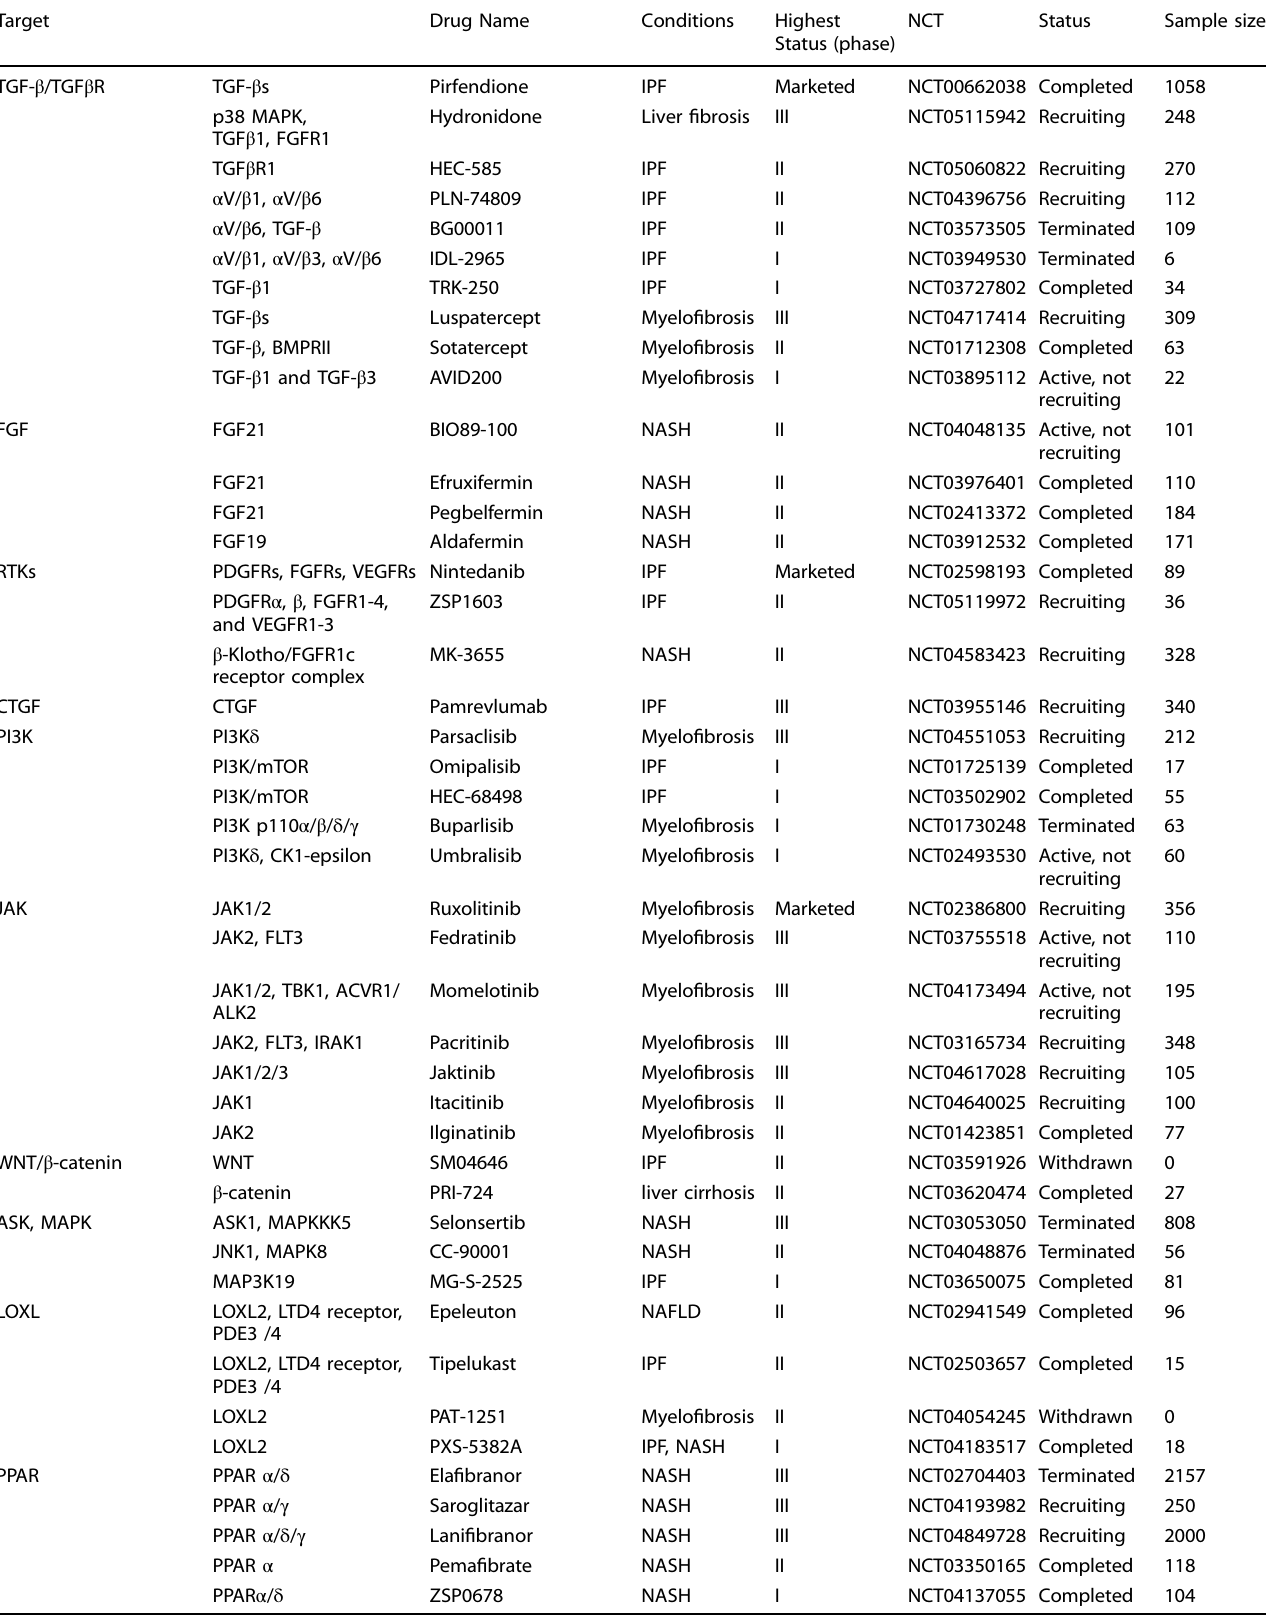
Table 1. Drug targets and NCT number of clinical trials